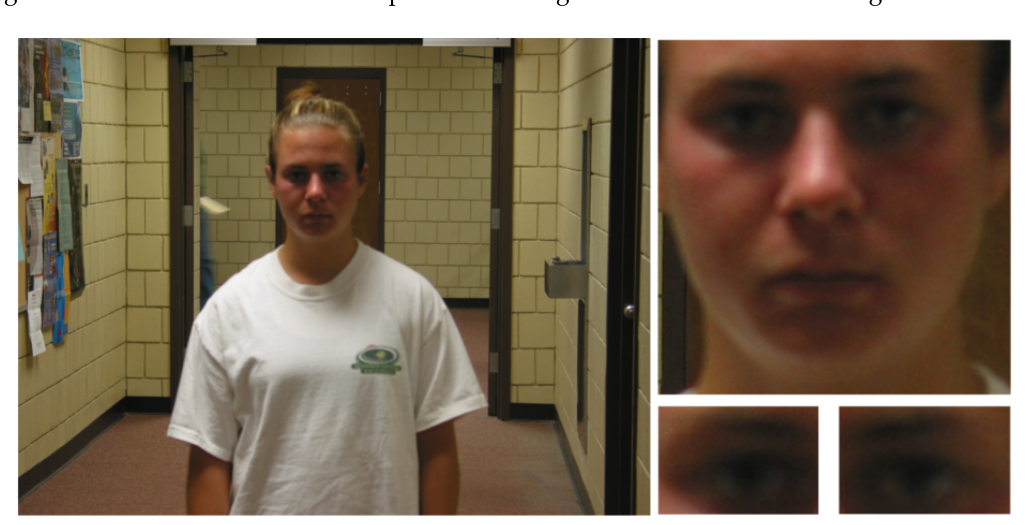
Figure 6. Example of the crops made from a random image of the FRGC dataset. Source: